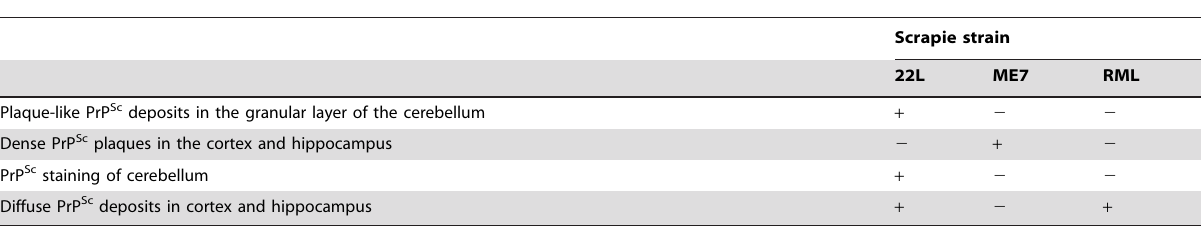
Table 4. Strain-specific diagnostic features in Tg a20 mice.